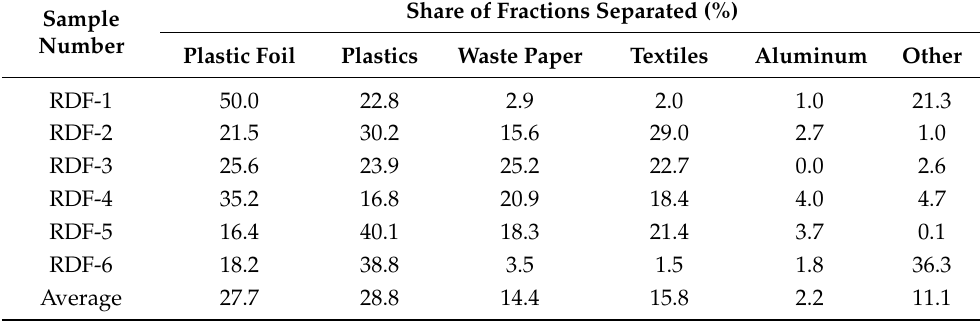
Table 1. Morphological composition of RDF samples.